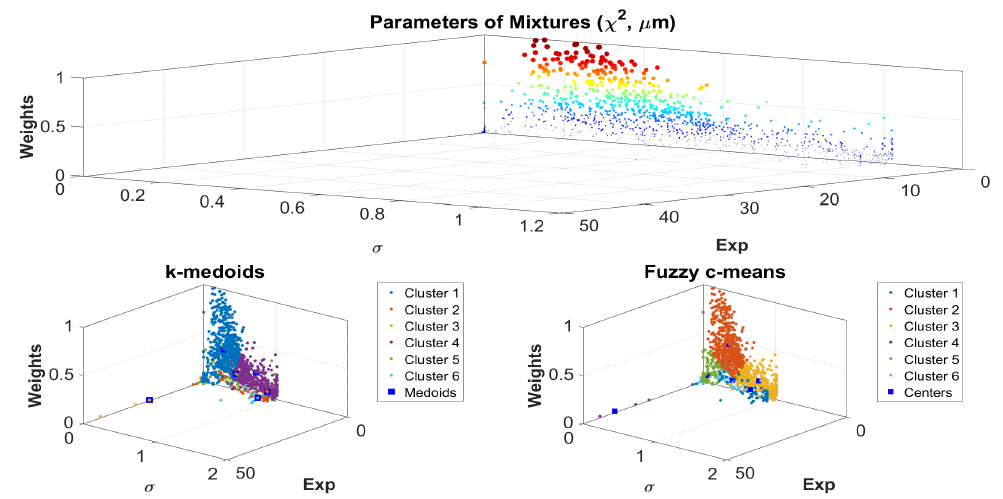
Figure A28. Clustering the mixture parameters (minimizing χ 2 estimates, µ m),